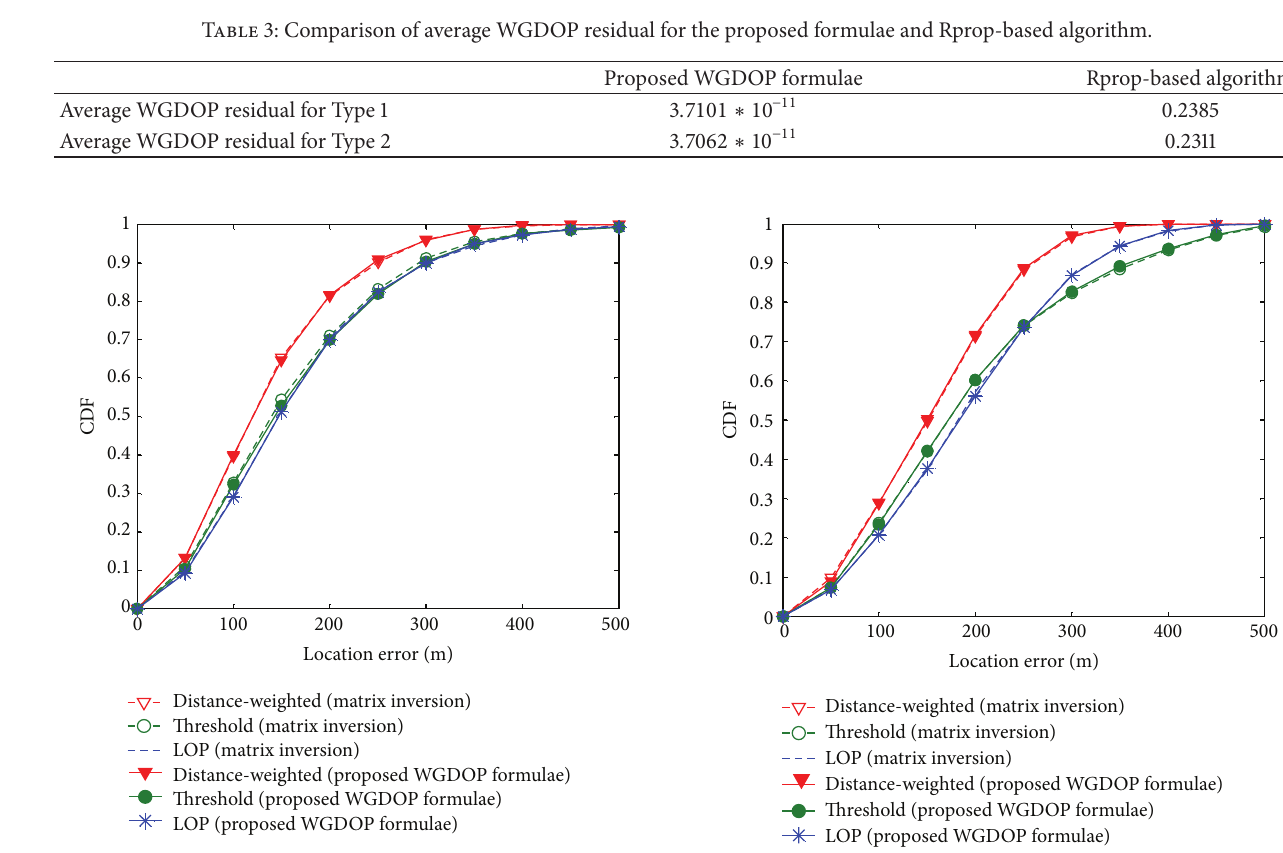
Figure 1: CDFs of the location error for various methods when four measurements have different error variances (Type 1).